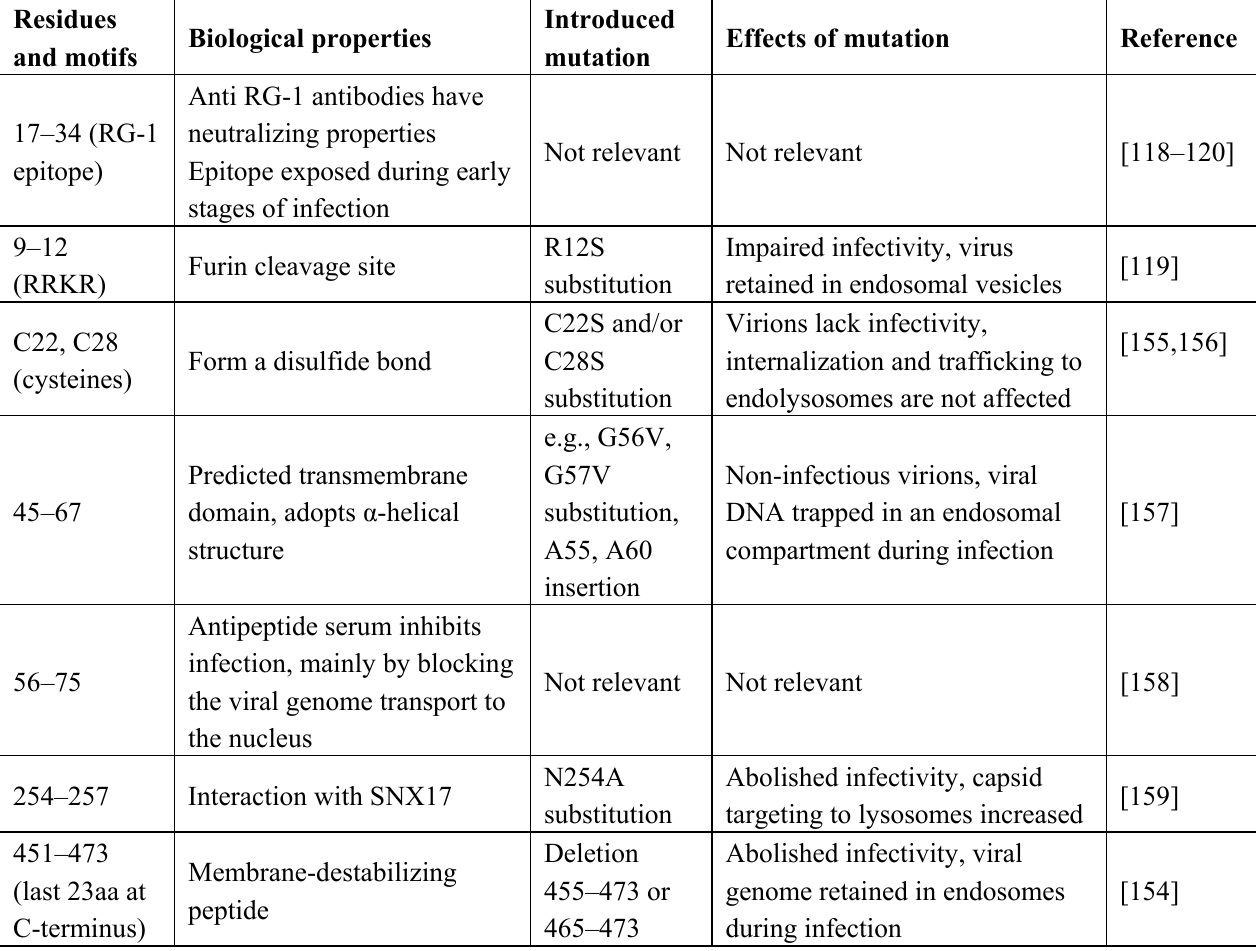
Table 2. Overview of HPV16 L2 protein residues and sequence motifs involved in the endosomal escape of the papillomavirus. The biological effects of mutations are included if